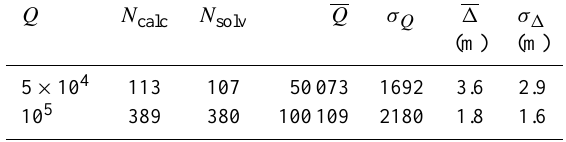
Figure 8. Contour plot of the log likelihood of a source at a given position (in meters, with + x representing east and + y representing north) with the detectors at the height z 0 = 1m, maximized over the leak rate Q , and referenced to Q = 0. (This convention implies that all values will be non-negative.) The maximum is in the red region at ( − 124, − 85). The secondary maximum near ( − 190, 100) is hundreds of log-likelihood units lower, even if the region to the left of the displayed area is considered. The structure in the figure is aligned with the light paths shown in Fig.